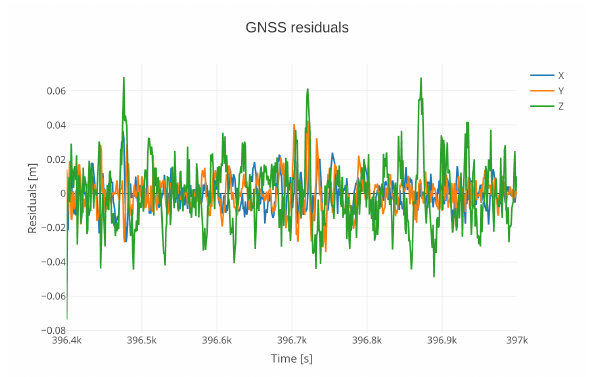
Figure 8. Histogram of the X , Y , Z residuals at the provided checkpoints (in m) and related statistics (in GSD units).